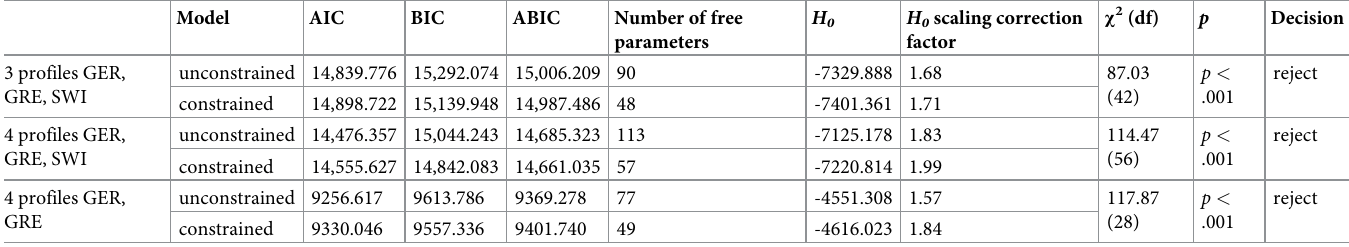
Table 4. Measurement invariance across